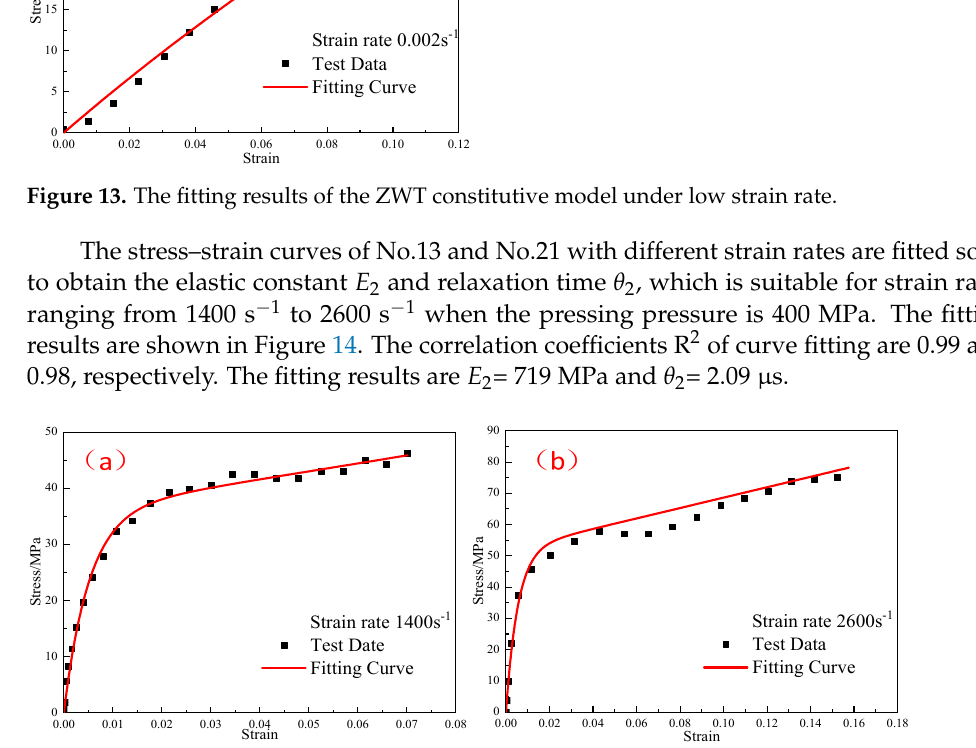
( b ) Figure 16. Comparison of the fitting results of the ZWT constitutive model with the experimental results under 800 MPa pressing pressure and different strain rates: ( a ) 1400 s − 1 ; ( b ) 2600 s − 1 . The parameters of the ZWT constitutive model obtained by different pressing pres- sures have been determined, and the parameters are listed in Table 4.